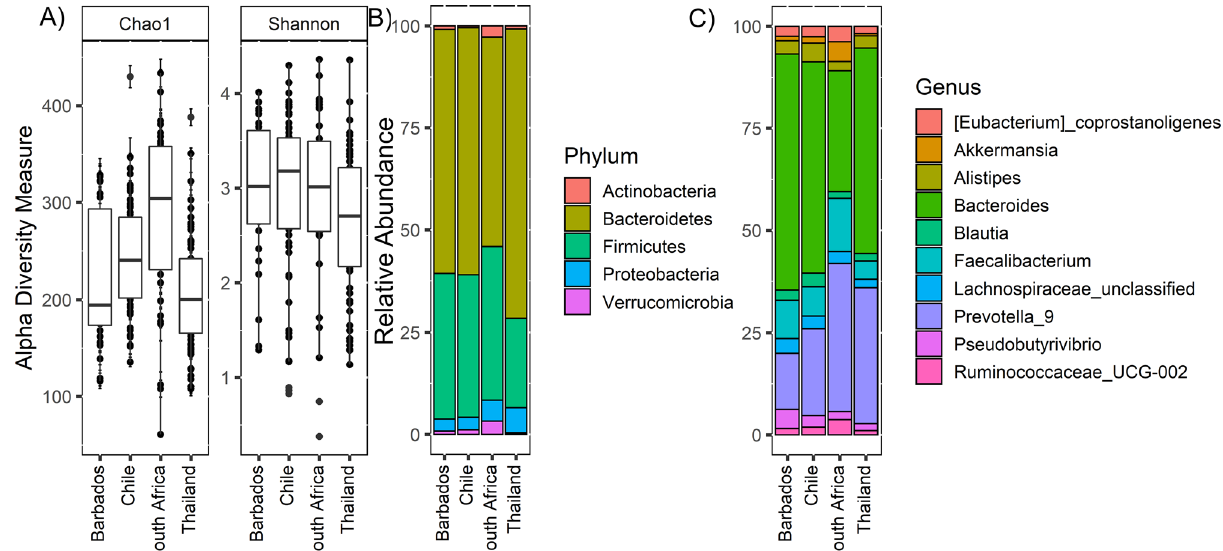
Figure 1. Stool alpha diversity: ( A ) microbial richness and evenness of cheek was calculated based on the Chao1 and Shannon index of four different sites. The y-axis represents the alpha diversity unit scale either